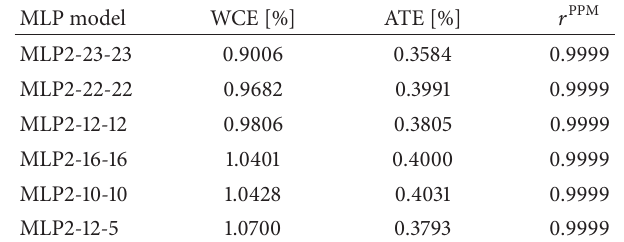
Table 3: Testing results for six MLP-DoA neural network models with the best test statistics.